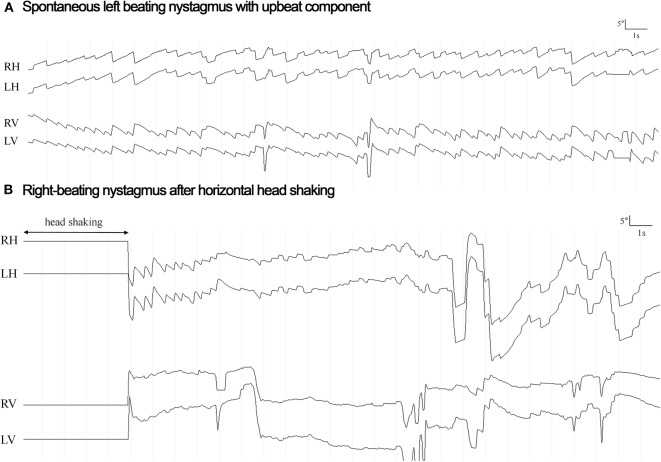
Horizontal eye position for the right eye (RH) and the left eye (LH) is plotted against time both at rest (panel A: spontaneous nystagmus) and after head shaking for 15 s (panel B: head shaking nystagmus) in a single patient (#8) with right lateral medullary infarction and normal responses on video-head-impulse testing. The direction of horizontal nystagmus is changed from left-beating (6.0°/s) to right-beating (21.4°/s) (toward the lesioned side) after head shaking, reflecting a central-type HSN response. Vertical eye position is also plotted both for the right (RV) and for the left (LV) eye.